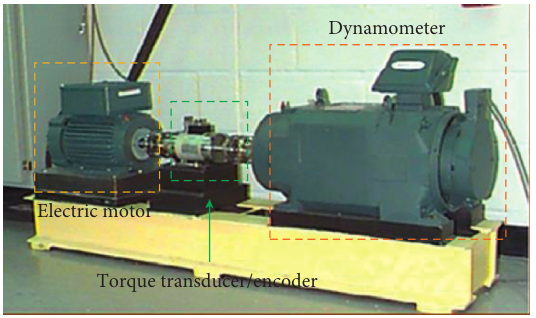
Figure 3: The test bench of SKF rolling bearing fault in CWRU.